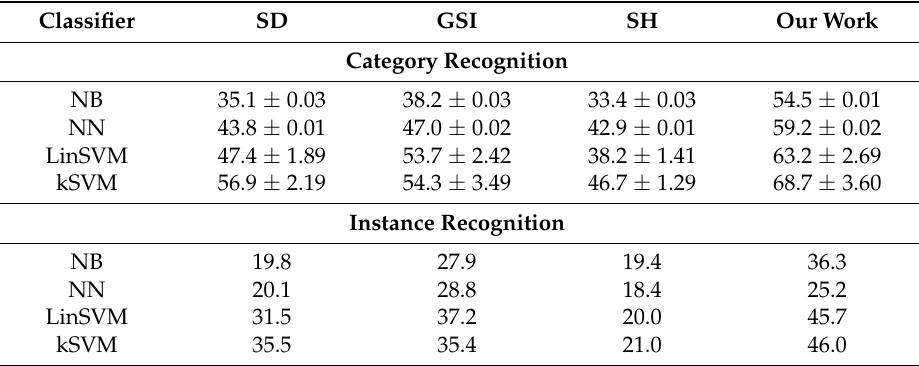
Table 1. Accuracies (in percentage) of four shape descriptors on the RGB-D Object Dataset. SD means shape distribution. GSI means global spin image. SH means shape histogram. ± refers to standard deviation.